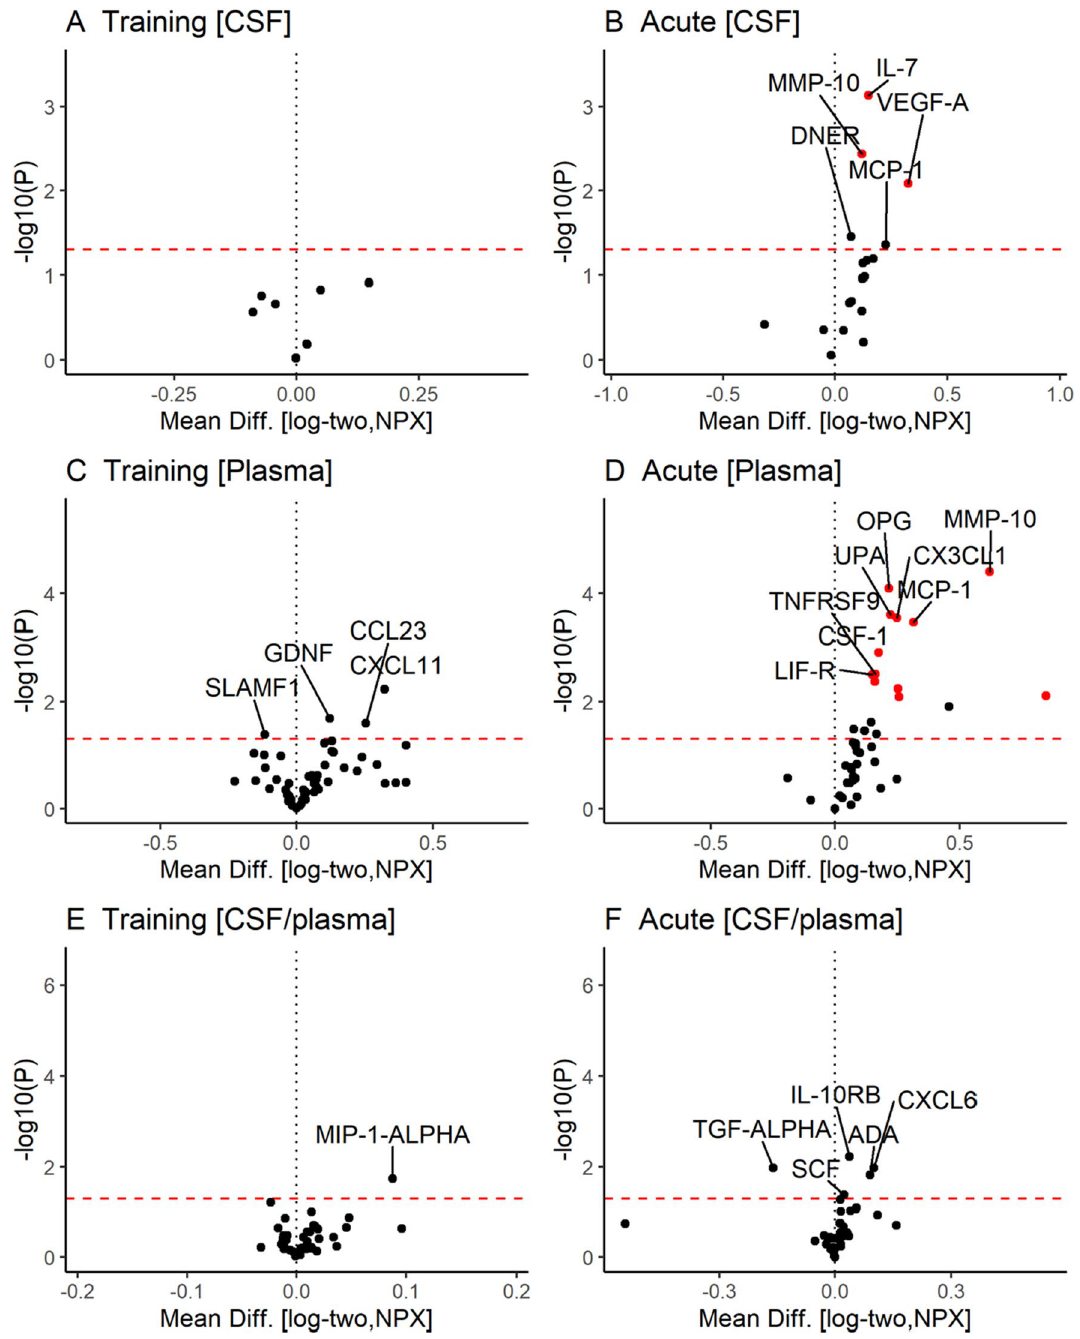
Figure 2. Changes in the immune marker profile of cerebrospinal fluid (CSF) and plasma after training and acute intervention exercise. Volcano plots summarize the mean difference and significance (P) from paired Student t-tests comparing baseline and follow-up levels of inflammation-related proteins after intervention with training [left] or acute [right] intensity exercise in CSF [first row], plasma [2nd row], and the ratio of CSF/plasma [3rd row]. The red dashed line indicates an exploratory cutoff of P = 0.05 and associations with P FDR < 0.05 are highlighted red. Associations where filtered to exclude effects by sample handling variability (Fig. S3). R Core Team (2017). R: A language and environment for statistical computing. R Foundation for Statistical Computing, Vienna, Austria. URL https:// www.R- proje ct.